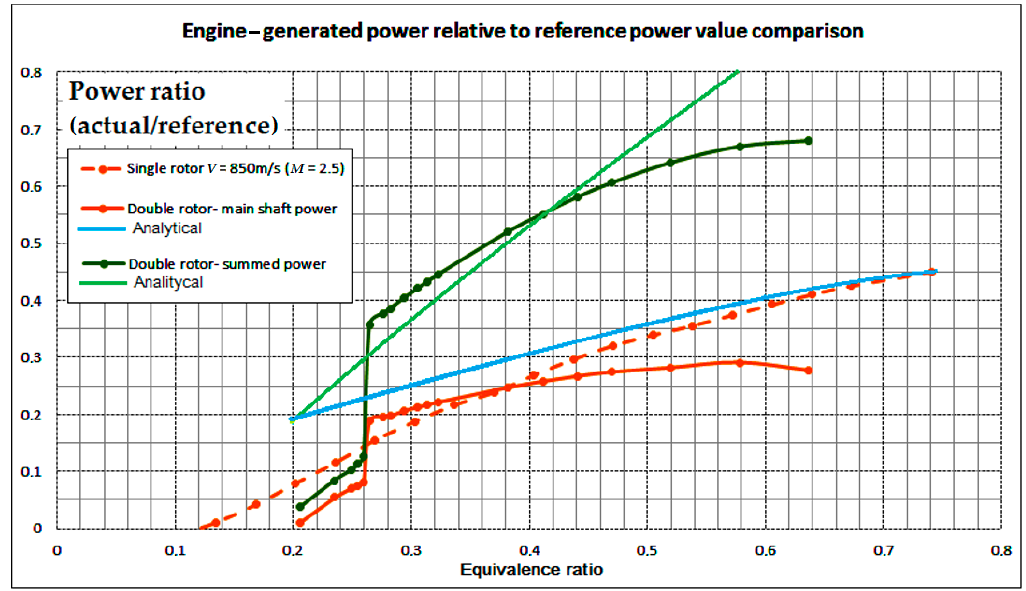
Figure 23. Variability of the generated power by a single-rotor and double-rotor engine and the power generated by its rotors.